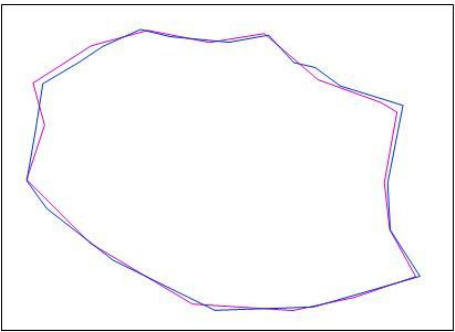
Figure 9. Two homologous geometric descriptions of the same geographic